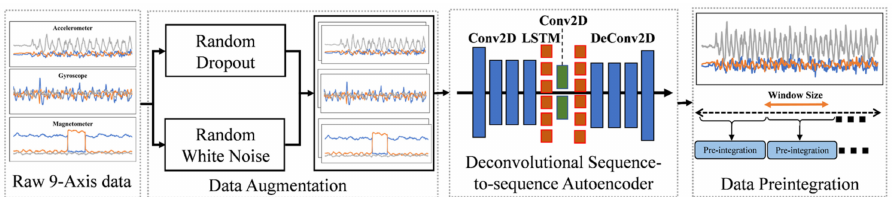
Figure 3. The framework of the data